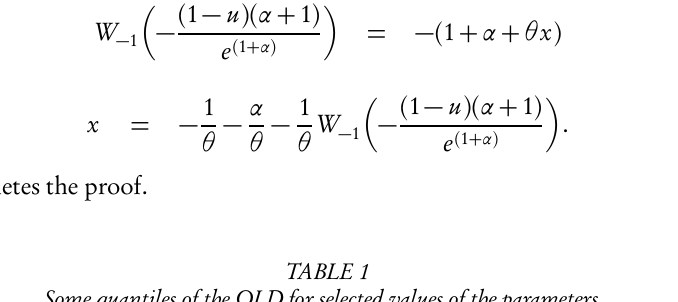
Some quantiles of the QLD for selected values of the